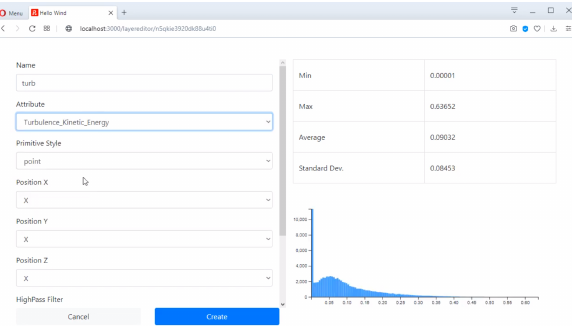
Figure 5. Creation/editing of a layer will re-render a new layout without a server